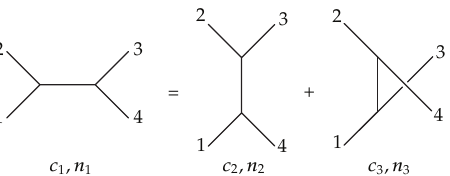
Figure 5: Diagrammatic representation of the Jacobi identity. The c i ’s can be obtained by dressing the (cid:17) vertices with structure constants f abc , but the diagrams can also be thought of as representing the kinematic numerators n i